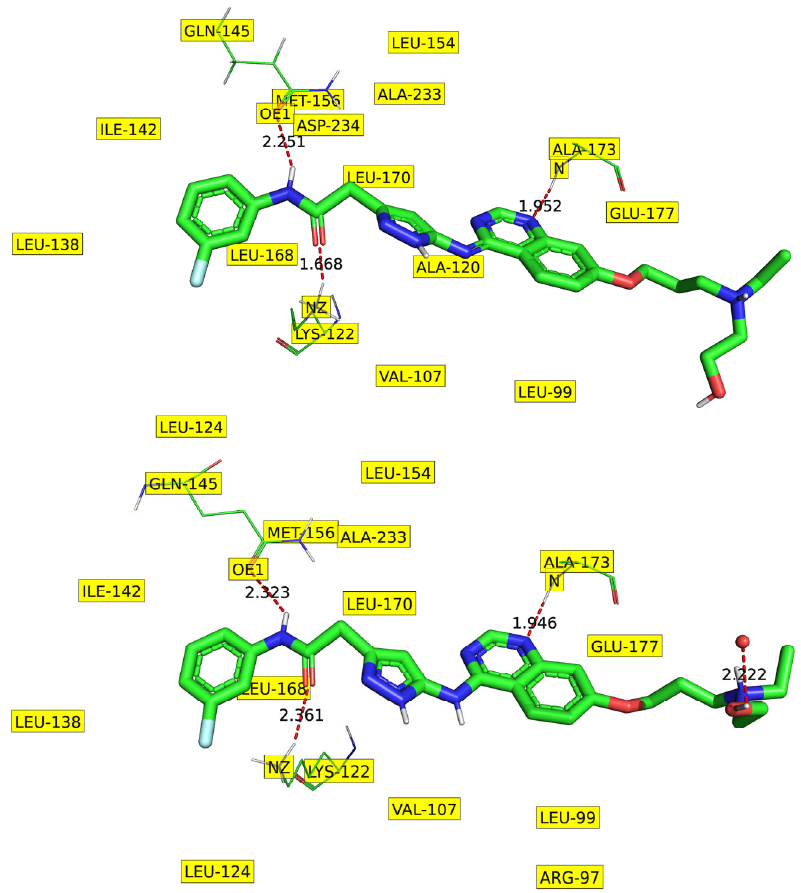
Figure 8. Depiction of prominent interactions of YJA ‐ T1 and T2 with the receptor (pdb: 4c2v). fsp2Osp2C5B: